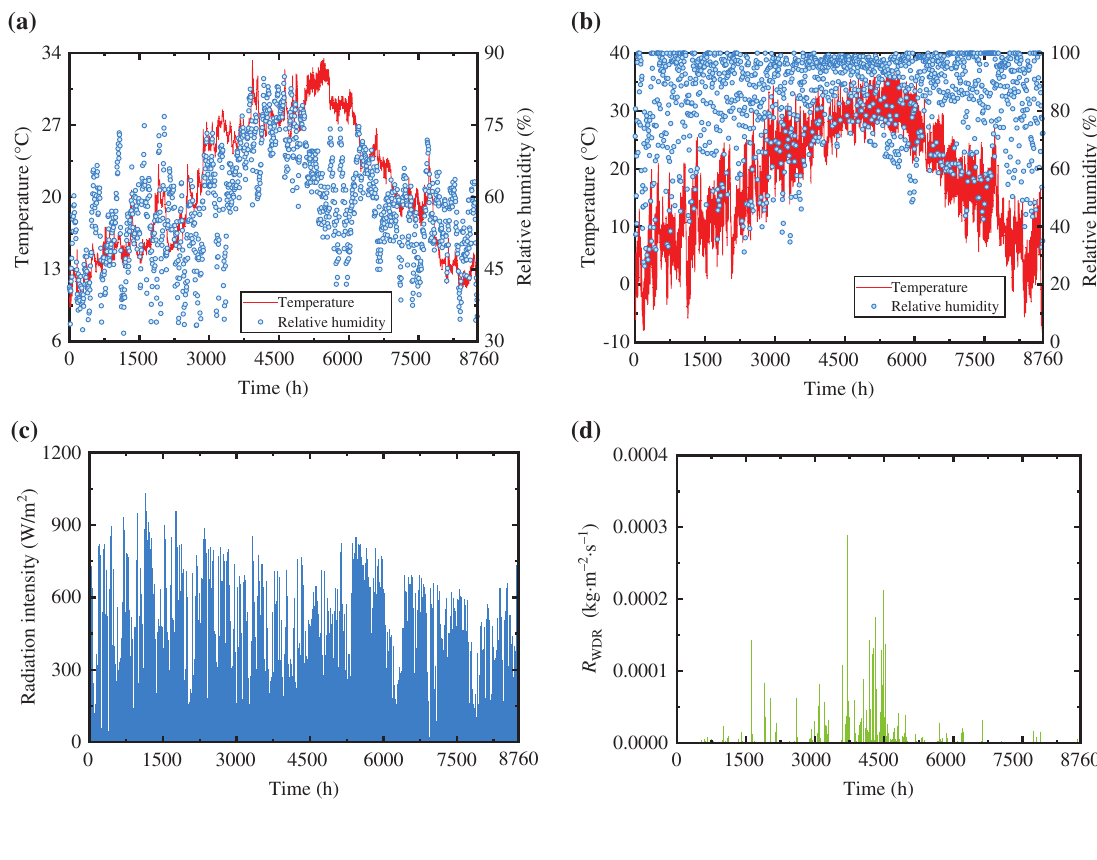
Figure 3 Ambient environment of WFTBs: (a) indoor temperature and relative humidity, (b) outdoor temperature and relative humidity, (c) radiation intensity I at the eastward vertical wall, (d) moisture load caused by wind-driven at the eastward vertical rain R WDR